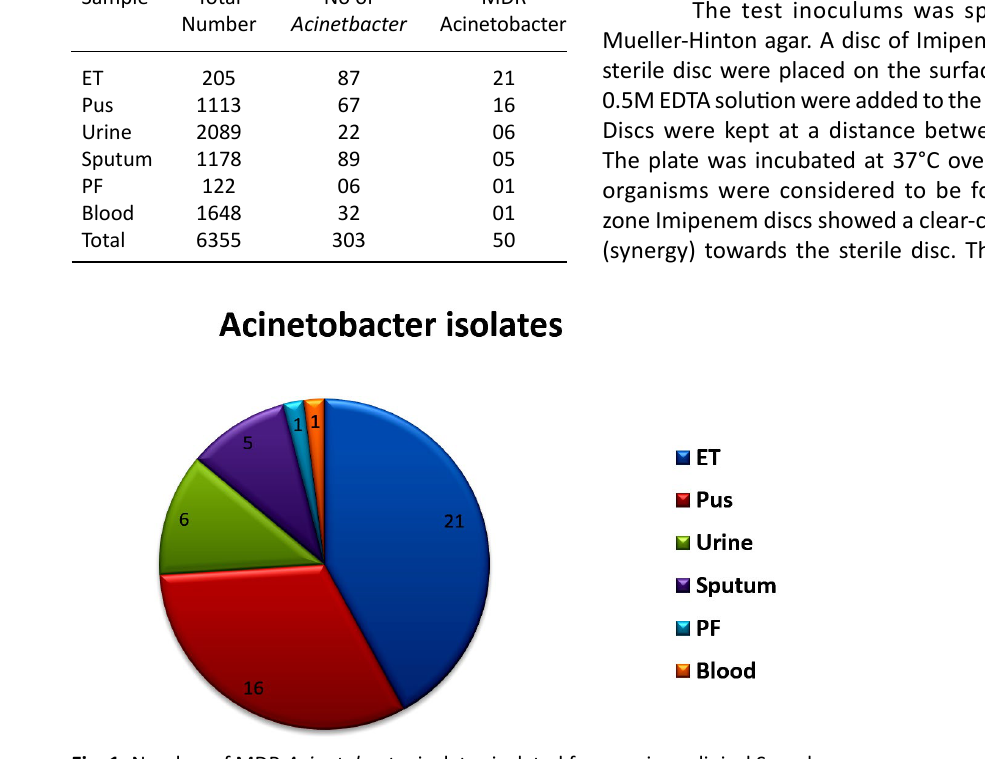
Fig. 1. Number of MDR Acinetobacter isolates isolated from various clinical